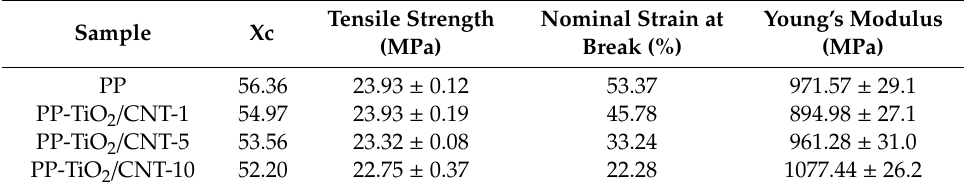
Table6. Tensilepropertiesofpolypropylene(PP)andPP-TiO 2 / CNT(carbonnanotubes)nanocomposites.